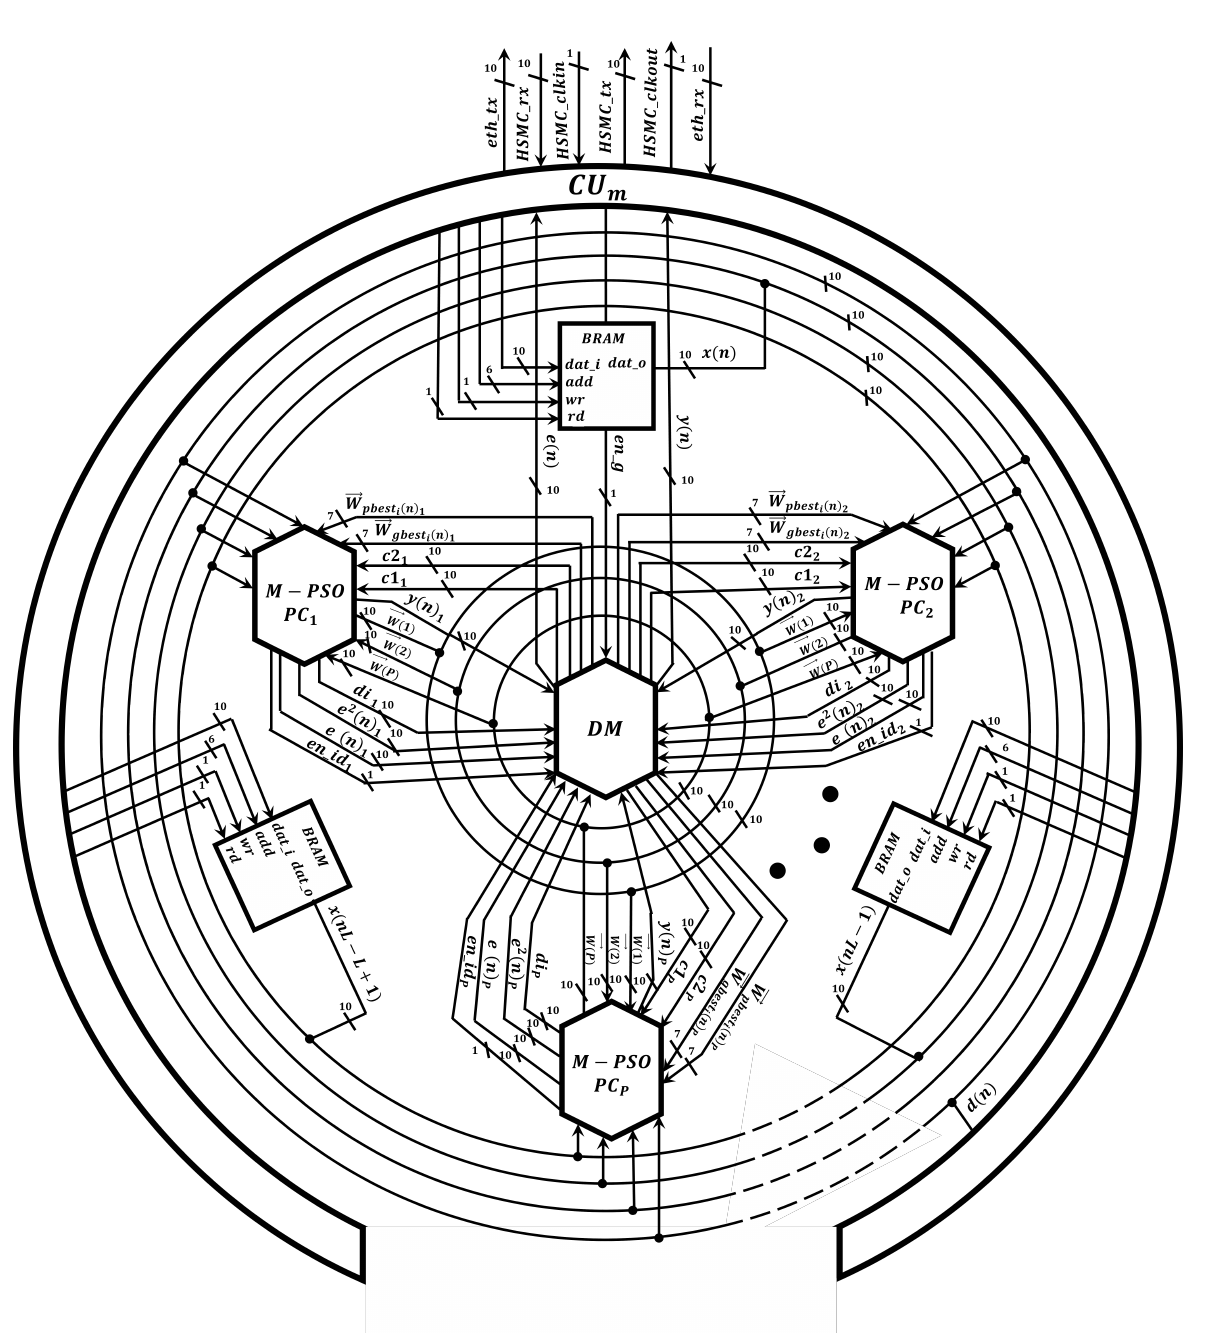
Figure 7. Digital implementation of the proposed Markov switching PSO algorithm in the parallel metaheuristic